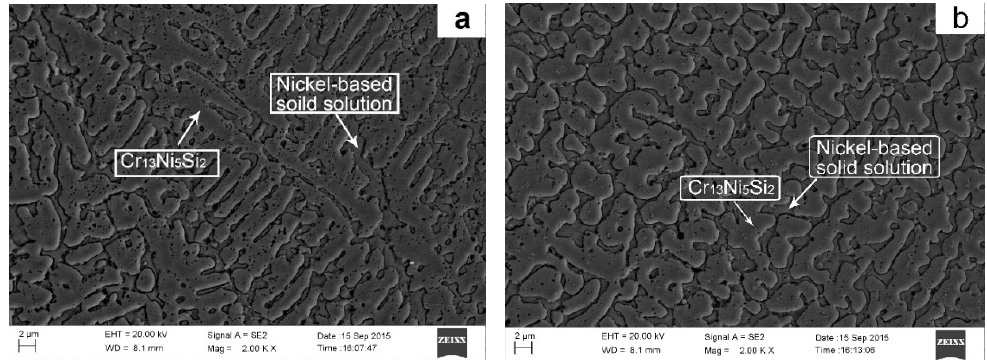
and ( b ) in upper regions of coating.